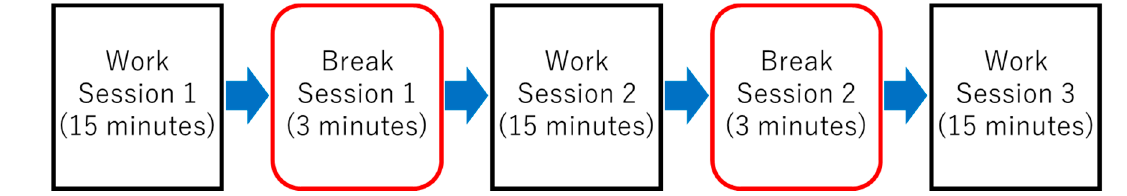
Figure 4. The flow of the mathematical calculation experiment. Table 1. The behaviours during the breaks and number of data in each group. The Contents of Behaviours The Number of Data